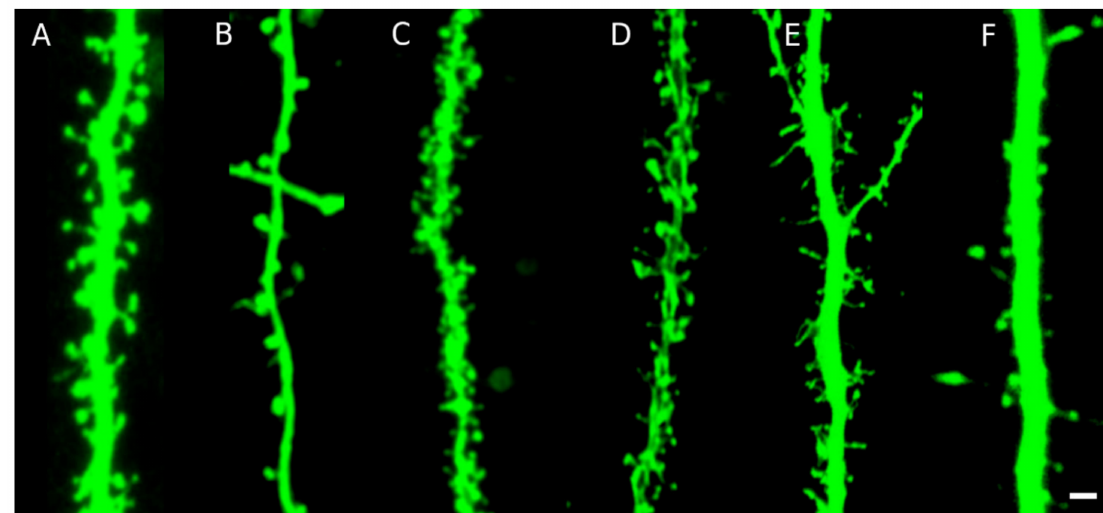
Figure 3. Different imaging modalities; fluorescent image of a dendrite with spines. Different types of neurons and staining techniques were used. The actual colors were changed in postprocessing to the green. ( A ) Live-cell imaging of primary hippocampal culture transfected with plasmid-encoded RFP ( B ) Confocal image combined with Airyscan processing of hippocampal fixed slices biolistically labeled with DiI staining ( C ) transcranial two-photon imaging of the motor cortex in a freely moving mouse. ( D ) Confocal image of organotypic hippocampal slice culture biolistically transfected with plasmid-encoded RFP. ( E ) Confocal image of fixed primary hippocampal culture transfected with plasmid-encoded GFP, ( F ) Confocal image of thick hippocampal brain slice marked with DiI. Scale bar: 2 µ